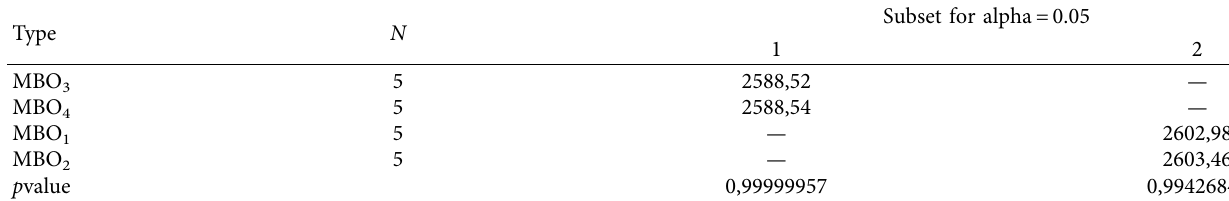
Table 9: Tukey’s test for the a280 instance.